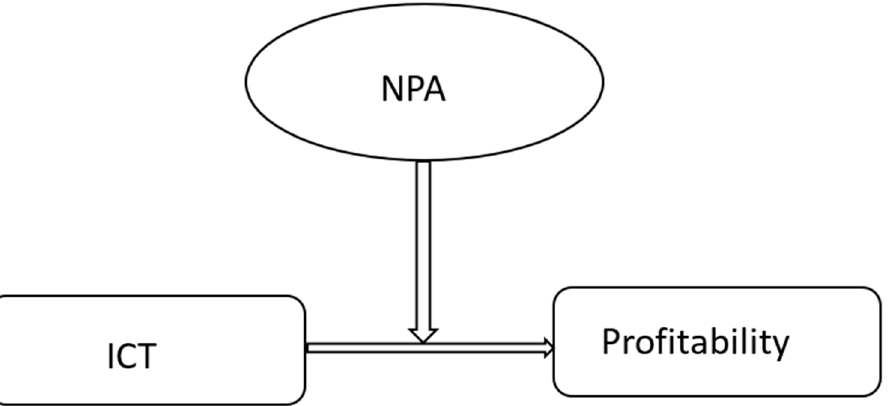
Figure 1. Conceptual Model. Note: ICT stands for Information and Communication Technology and is an independent variable. NPA stands for Non-Performing Assets and is a moderator. A firm’s profitability is determined by its expenses and revenue. An effective business will generate higher revenue and keep expenses lower. Source : Author’s compilation.